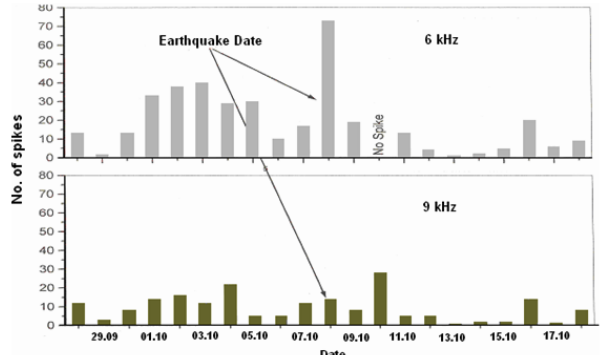
Fig. 13. Variation of spike intensity before and after the earthquake.